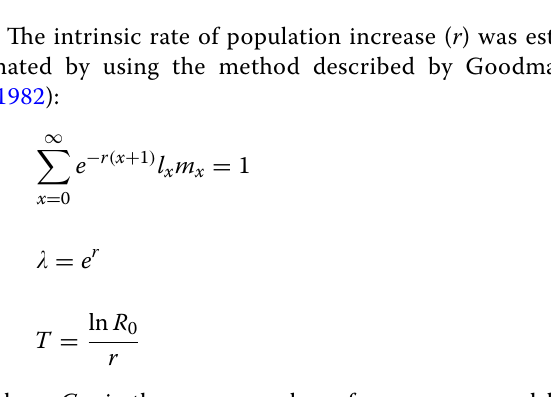
Table 1 Developmental and adult longevity of Blattisocius mali fed on eggs and larvae of Tyrophagus putrescentiae